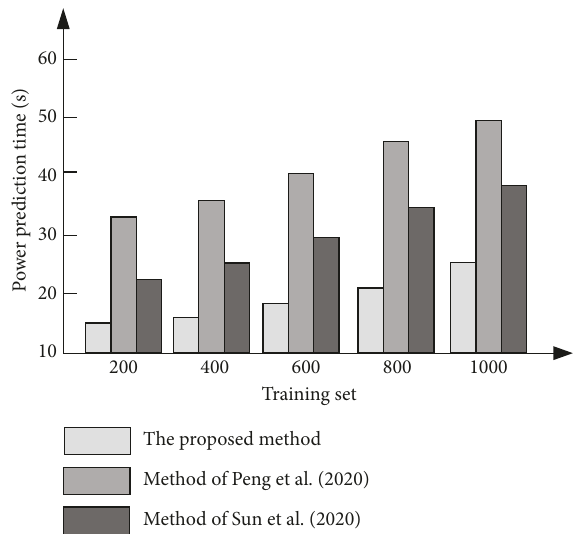
Figure 7: Comparison results of different methods of offshore wind turbine generating power prediction time. Table 2: Comparison results of different methods of offshore wind turbine generating power prediction errors. The proposed method Training set